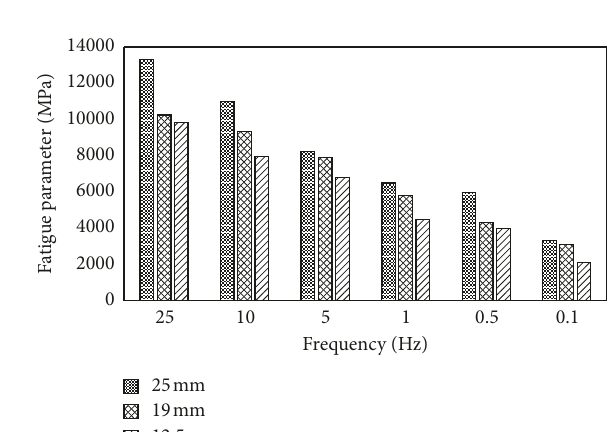
Figure 5: Fatigue parameter of SMA mixtures at 21 ° C.